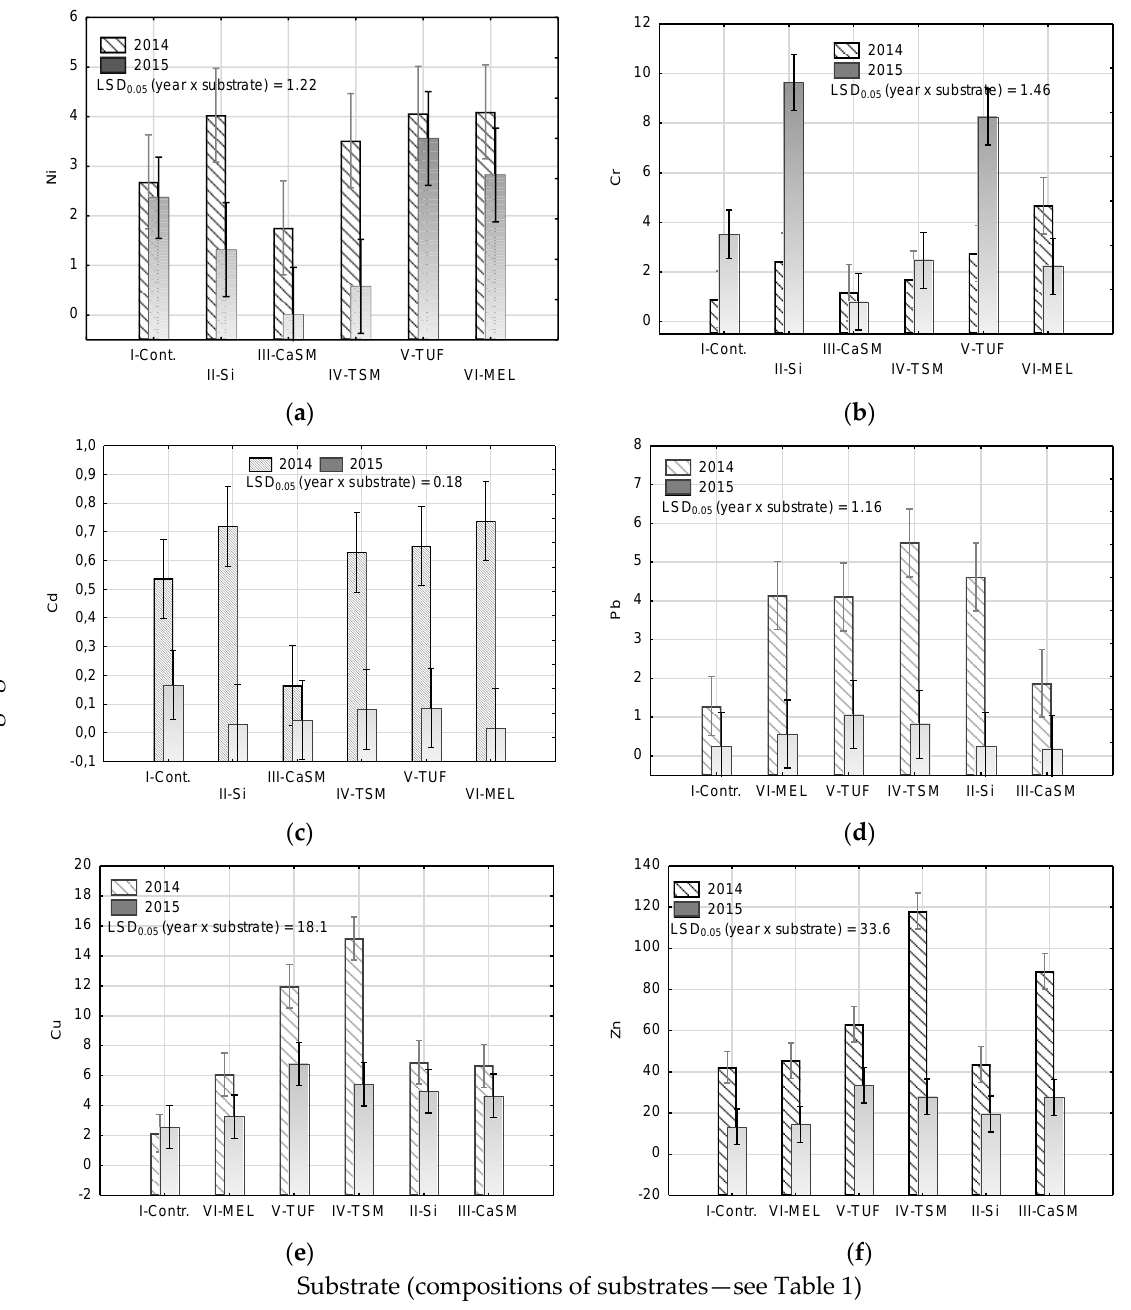
Figure 5. Trace element ( a – f ) concentrations (mg kg −1 d.m.) in the biomass of Sedum acre L. grown in six different green roof substrates during the two-year experiment.